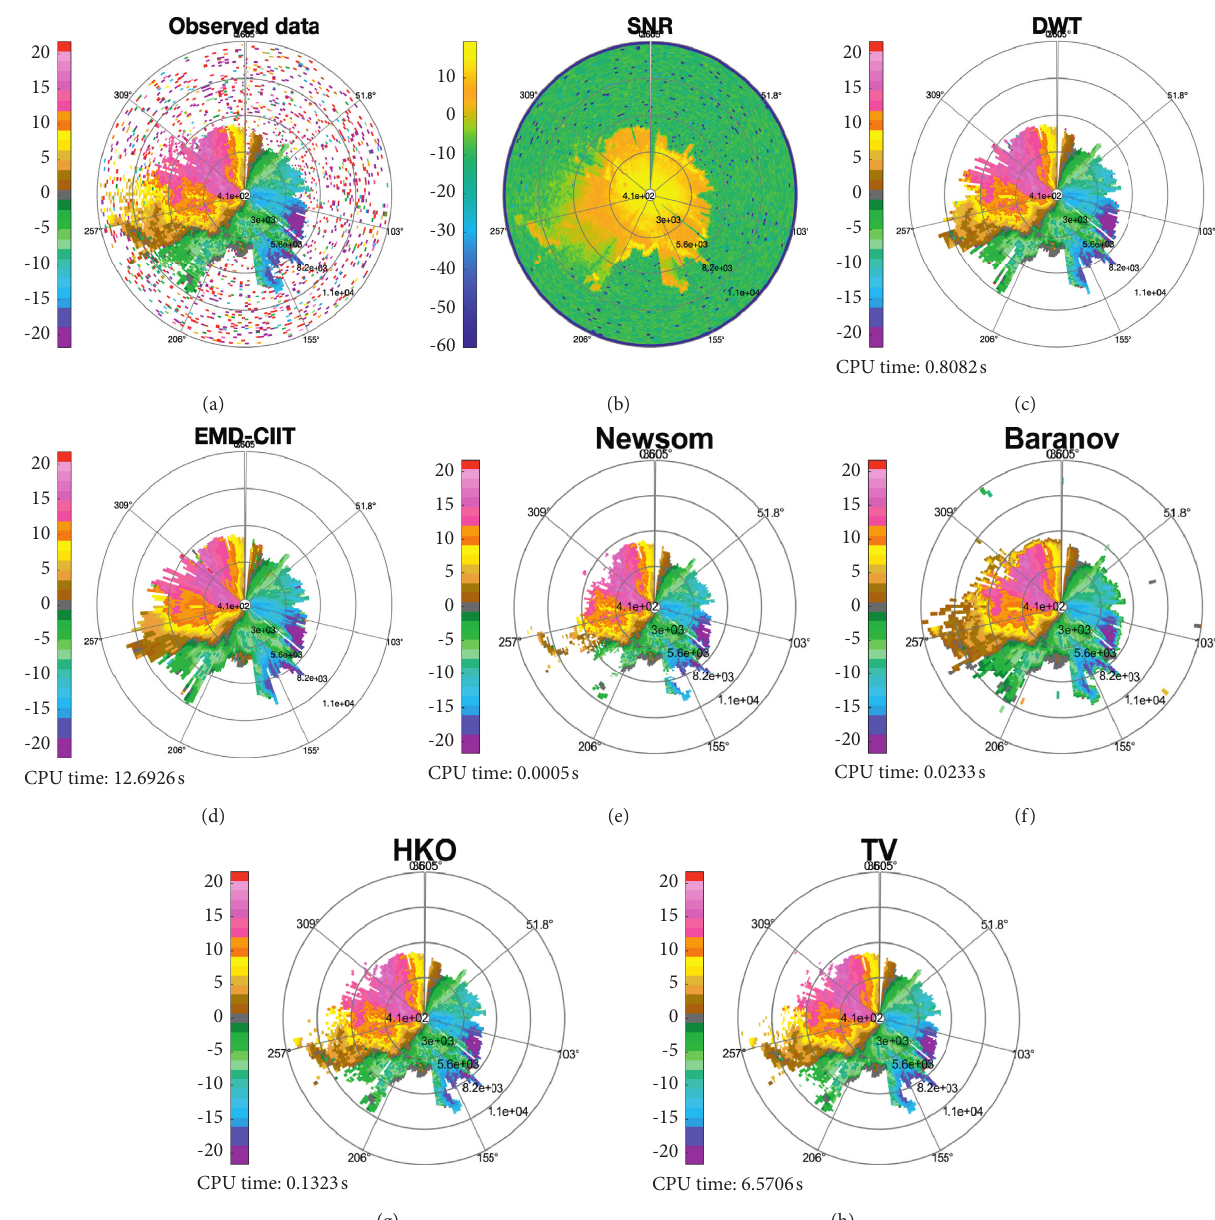
Figure 7: (a) The LiDAR data and (b) SNR values collected on 4 March 2015 from 21 :26:16 to 21: 46:39. The denoising results by (c) the “DWT” method, (d) the “EMD-CIIT” method, (e) the “Newsom” method, (f) the “Baranov” method, (g) the HKO method, and (h) the proposed scheme (denoted by